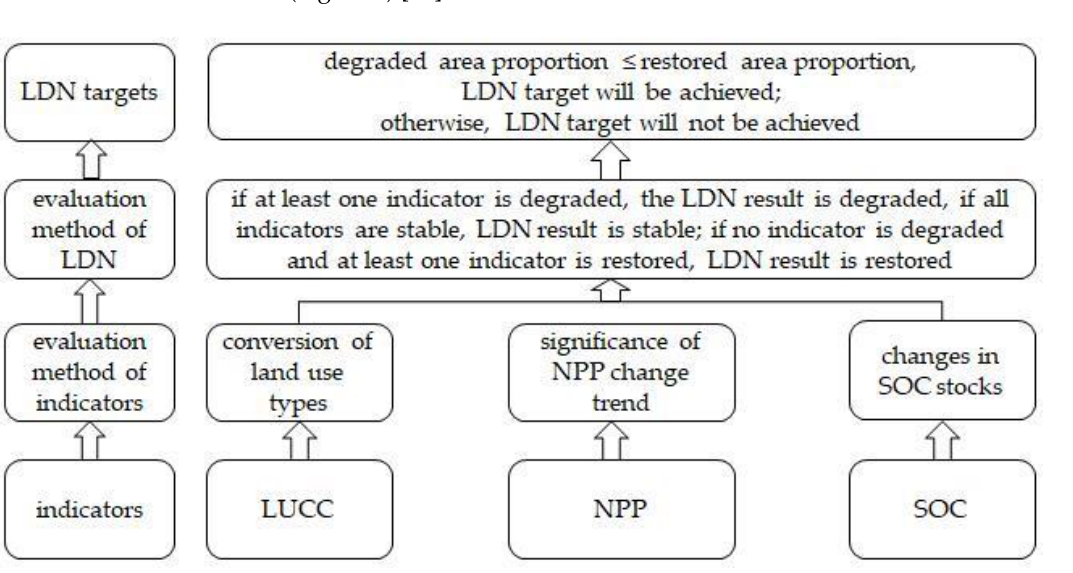
Figure 1. Rules for LDN evaluation.